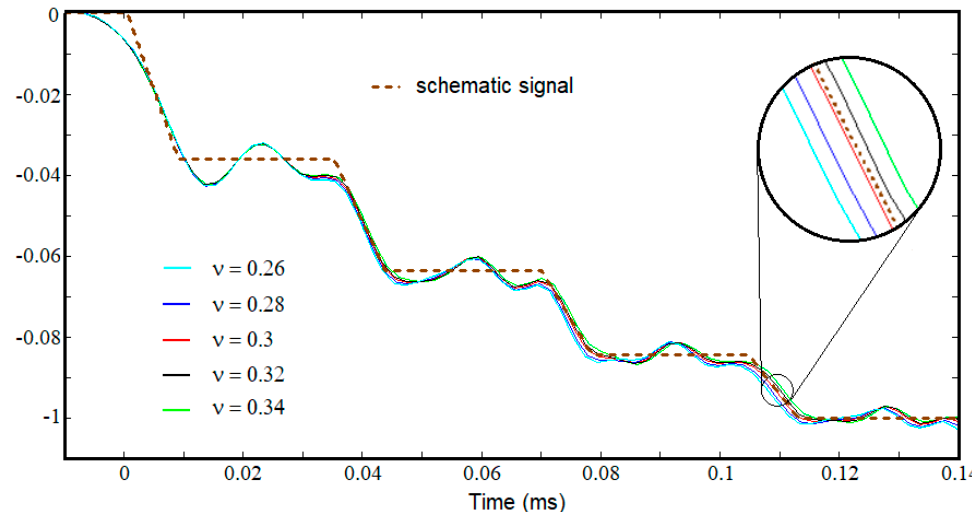
Figure 8. Comparison of schematic signal with the simulations results.